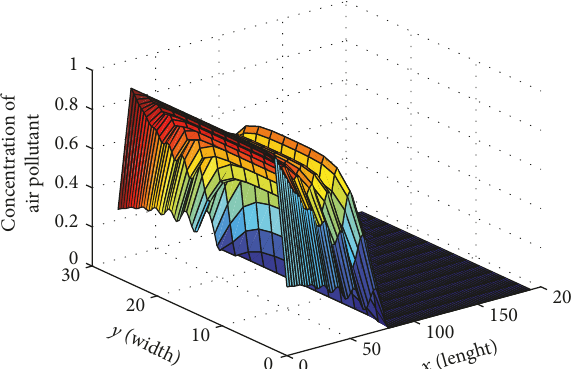
Figure 9: Contour plot of concentration of air pollutant levels for 𝑅 = −0.007 sec −1 .